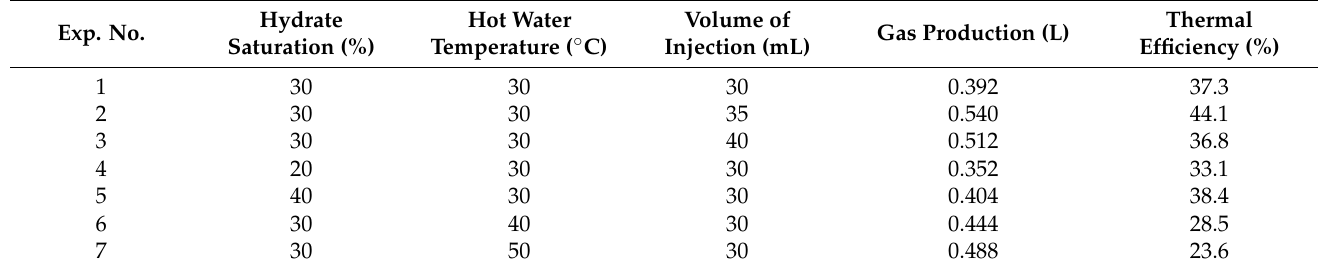
Table 2. The initial experimental conditions and the results of CH 4 production by hot water injection.